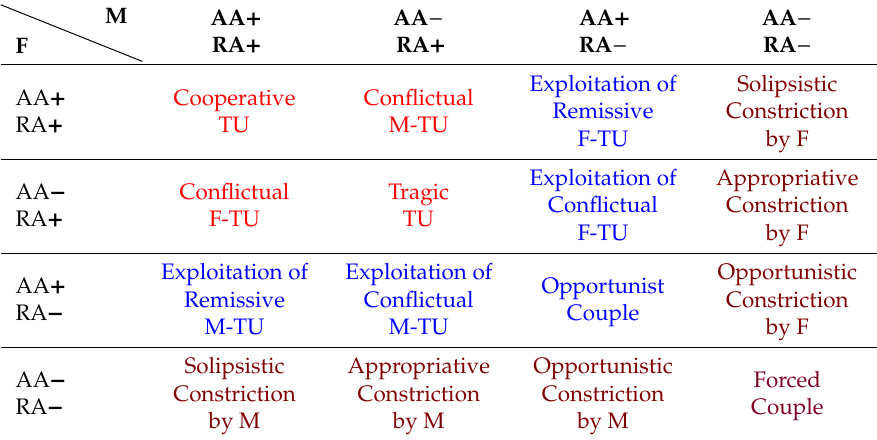
Table 1. The mating stability matrix